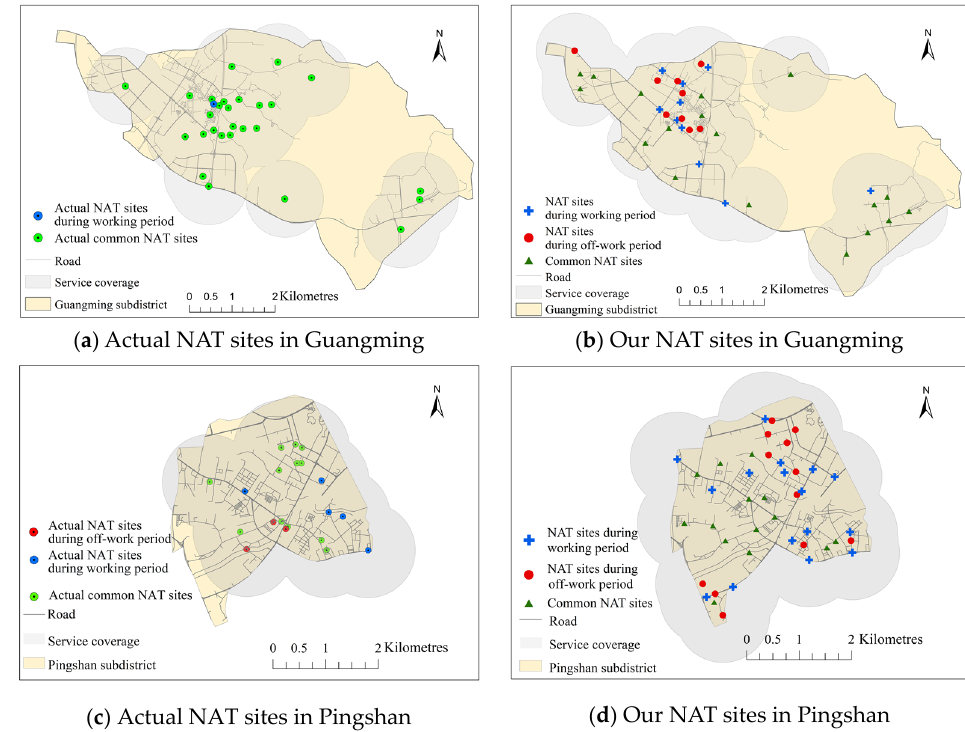
Figure 13. Layout of actual NAT sites, and the NAT sites used in this study. Table 4. Comparison of the actual scheme and our scheme, in two selected subdistricts.